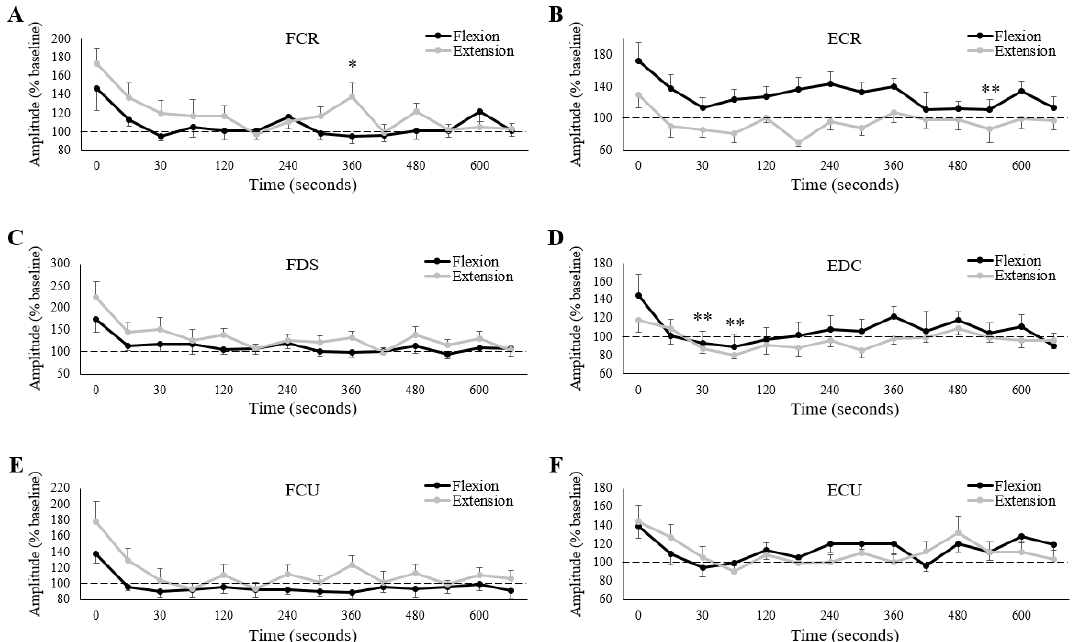
Figure 7. Group averages of normalized (% of baseline) MEP amplitudes for A) FCR, B) ECR, C) FDS, D) EDC, E) FCU and F) ECU. Black/grey lines are muscle activity collected on the wrist flexion/extension fatigue sessions, respectively. Horizontal dashed lines represent baseline (pre-fatigue) values. The x -axes denote time, with “0” representing the first measurement immediately after the cessation of the fatigue-inducing trial. All unlabeled points occurred 15 s after the preceding time point. * denotes a significant difference between sessions at a single measurement point. ** denotes a significant difference of a single measurement point (across both sessions) to “0” . Error bars represent standard error.